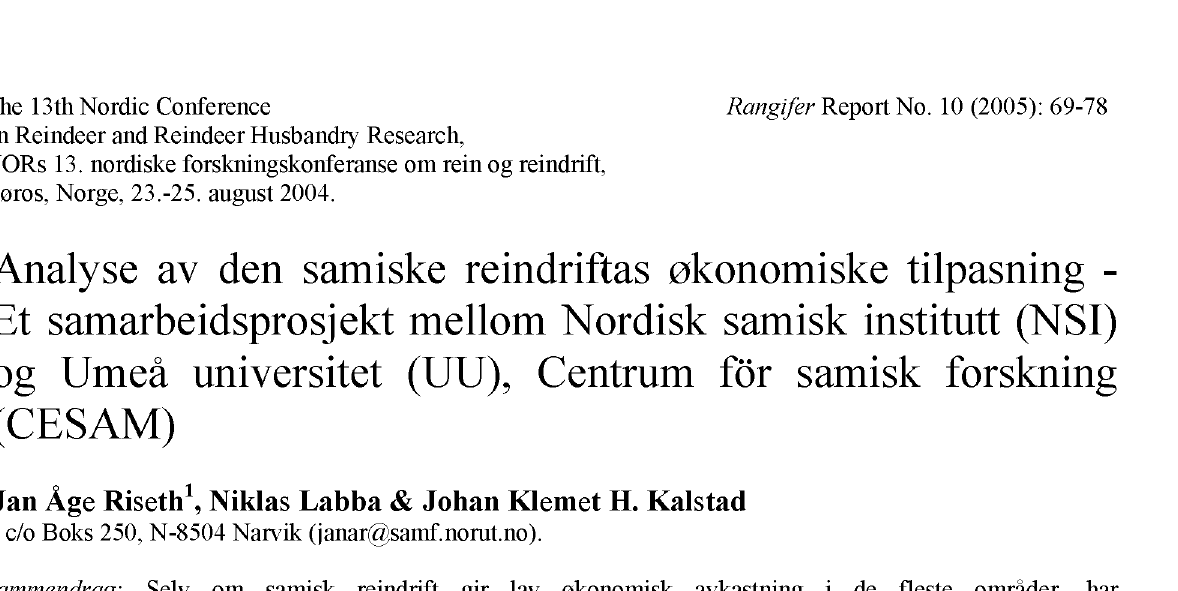
reindriftsbefolkningen vært voksende de seneste tiårene. Dette avviker fra det en skulle forvente ut fra en moderne formålsrasjonalitet. Det er mye som tyder på at reindriftssamene praktiserer det Weber kaller en substansiell rasjonalitet. Foreliggende analyser tyder på nær sammenheng mellom landskap, driftsform og type rasjonalitet i reindrifta. Prosjektet bygger på to overordnede hypoteser: 1) Livsformhypotesen: reindrifta har en egenverdi for utøverne som gjør at de aktivt velger å bli i næringen, 2) Kapitalhypotesen: manglende aner¬ kjennelse av reindriftsamenes ressurser som kapital har vært/er en bremse på deres etablering av kapitalkrevende virksomhet. Prosjektet skal analysere reindriftas økonomi basert på undersøkelser i flere typer reindrift både i Norge og Sverige, i nordsamisk og sørsamisk område. Det skal gjennomføres både kvantitative og kvalitative analyser i utvalgte regioner, med fokus på husholdsnivå for å kartlegge hovedtrekkene i reindriftssamenes økonomi. Fokus i de kvantitative analysene er dannelse og omfang av verdistrømmer i reindriftshusholdene og deres nærmeste omgivelser. I de kvalitative analysene er utgangspunktet beslutningssituasjoner og strategiske valg hos reindriftssamer. På grunnlag av de regionale analysene gjennomføres komparative analyser for å finne hvor representative funnene i de regionale studiene er. Prosjektet startet 01.07.2004 og er finansiert for 2!/!> år fra Norges forskningsråd (Program for samisk forskning), Interreg (Interreg IIIA Såpmi & Åarjelsaemie dajve), Sametinget i Sverige og egenfinansiering fra NSI og UU. Prosjektet har like etter oppstart to forskere i